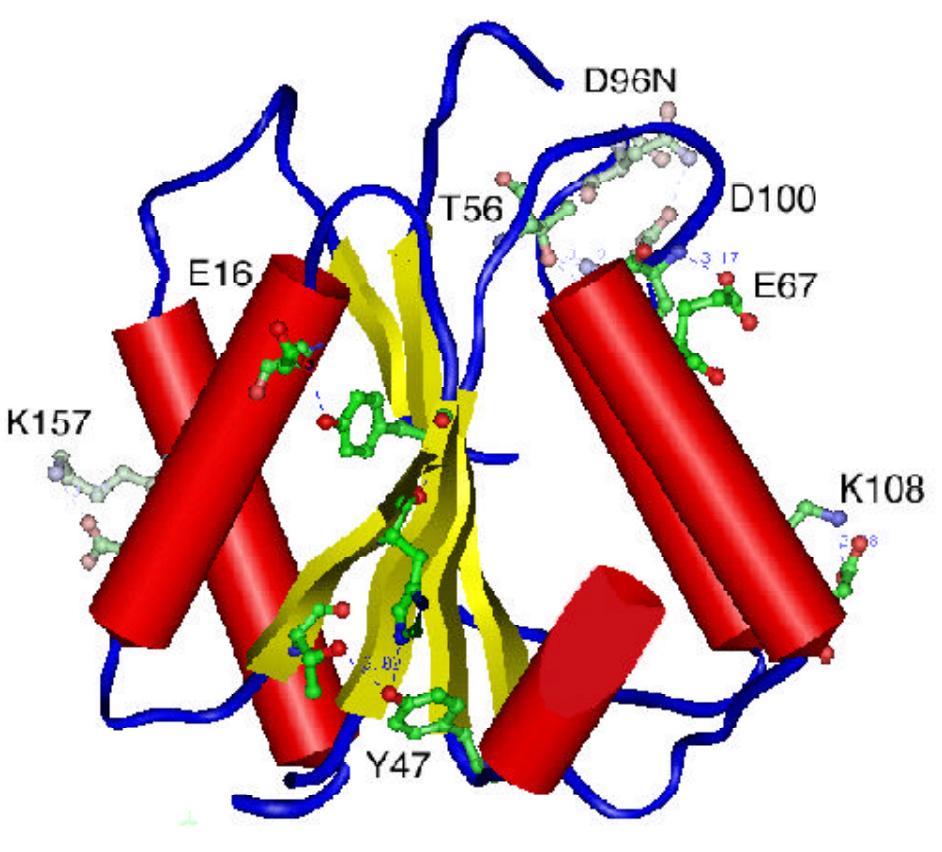
FIGURE 2. Ribbon diagram of apoflavodoxin secondary structure showing mutated hydrogen